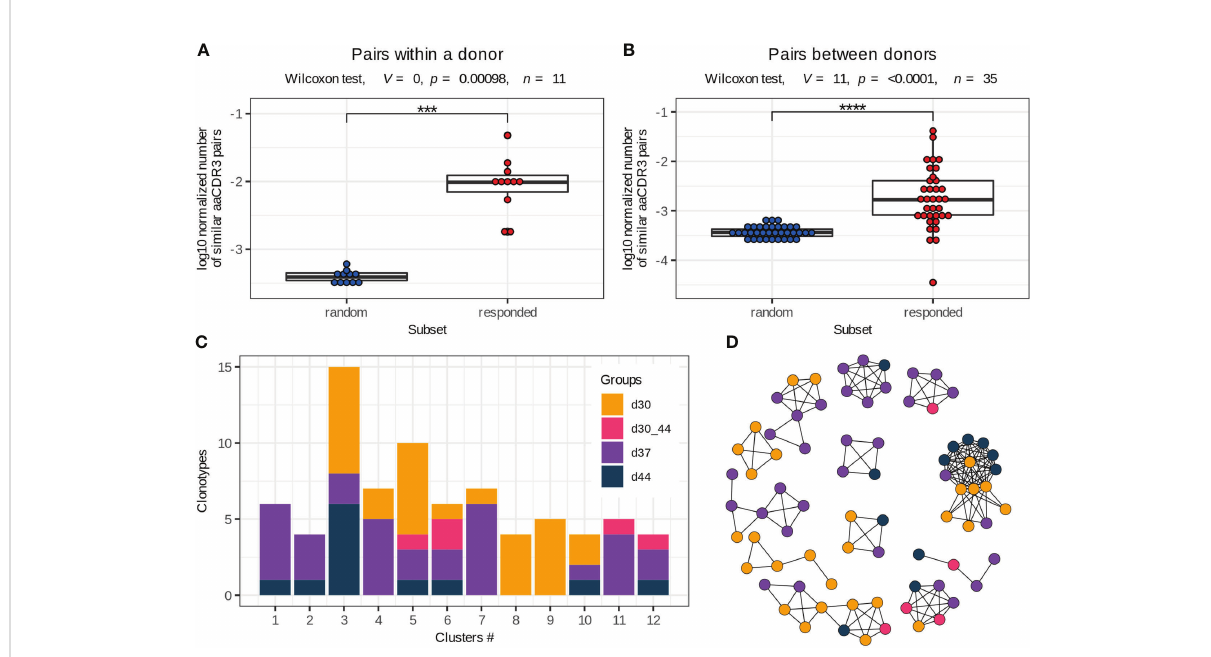
FIGURE 4 Vaccine-associated clonotypes with similar TCR b amino acid sequences. (A, B) Pairs of similar TCR b amino acid sequences (identical V and J segments and CDR3 length, with one or no mismatches in CDR3 amino acid sequences) for the responded and random clonotypes within a donor (A) and between two donors (B) normalized by the number of possible pairs in each subset. Paired two-tailed Wilcoxon signed-rank test was used (***p < 0.001, ****p < 0.0001). (C) Group distribution in the clusters of responded clonotypes with similar TCR b amino acid sequences (example for donor #1). Only 2 of 12 clusters consist of clonotypes of the same group. (D) Sequence similarity network for the responded clonotypes of donor #1. Each vertex corresponds to a unique TCR b clonotype, and edges connect clonotypes with one or no mismatches